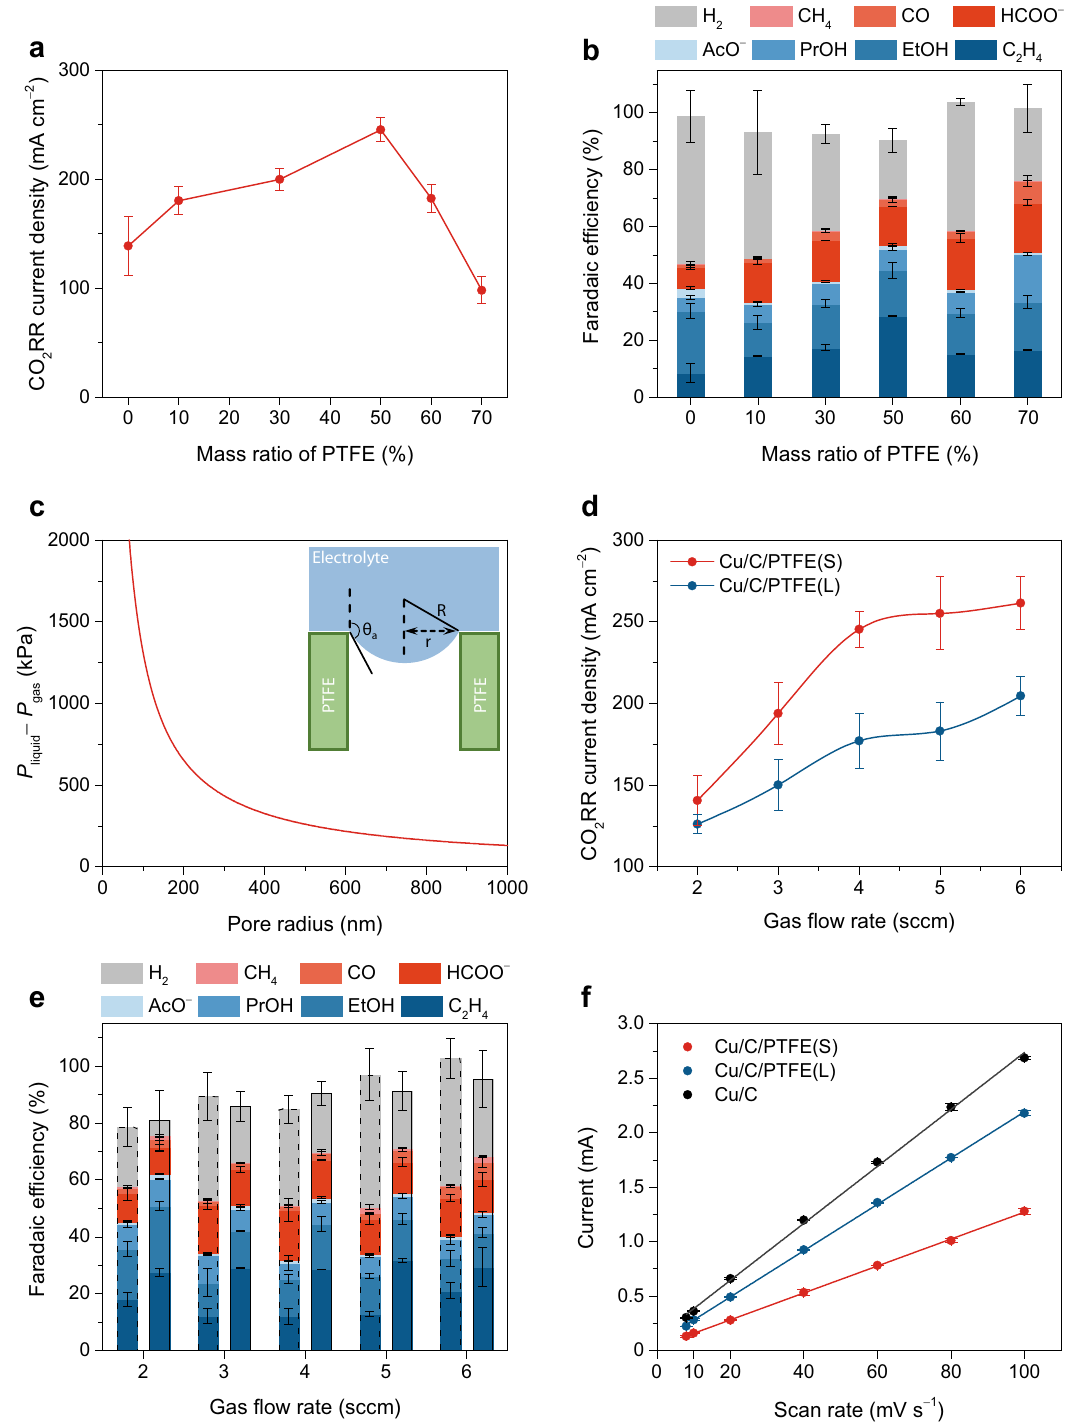
Fig. 4 Effects of PTFE loading and size on the microenvironment for CO 2 RR in GDE cell. a Partial current densities and b Faradaic ef fi ciencies for CO 2 RR at − 1.0 V on Cu/C/PTFE electrodes with different mass ratios of PTFE in the catalyst layer. c Pressure difference sustained across the liquid – gas interface in nano-sized pores as a function of the pore radius. Inset: schematic of the interface advancing inside a pore. d Partial current densities and e Faradaic ef fi ciencies for CO 2 RR on two Cu/C/PTFE electrodes with different PTFE particle sizes. In e , the left column with dashed line frame at each fl ow rate is for the Cu/C/PTFE(L) electrode and the right column with solid line frame is for the Cu/C/PTFE(S) electrode. f Double-layer charging current plotted against the CV scan rate for the electrodes. The error bars represent the standard deviation of three independent